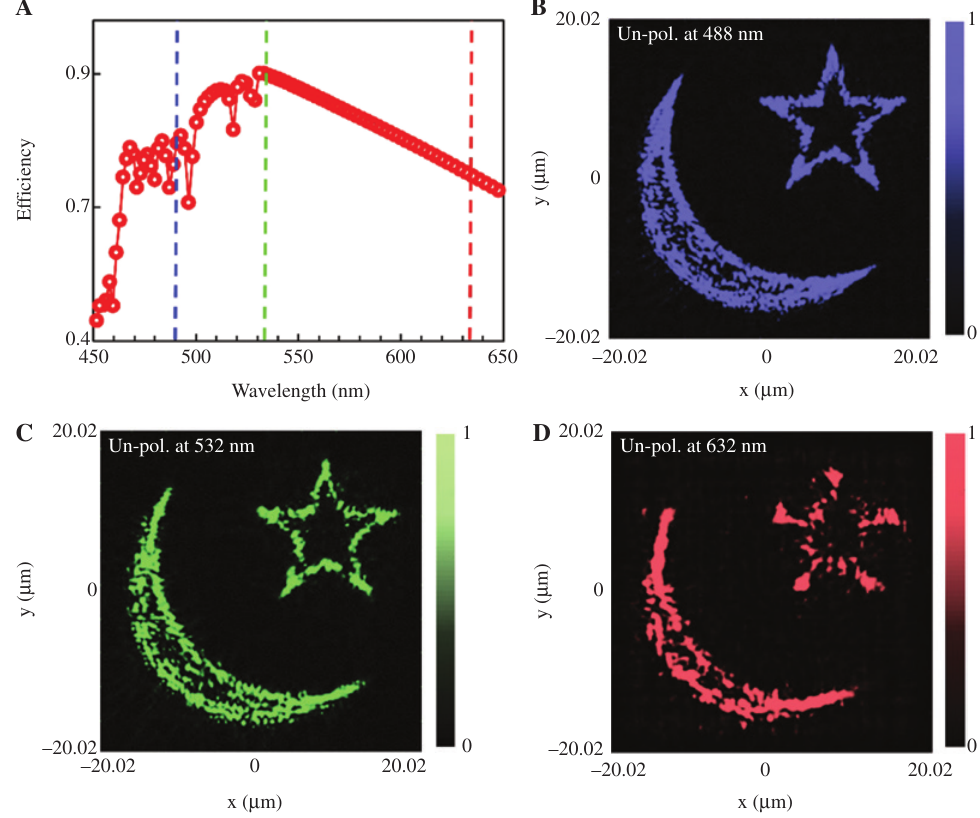
Figure 4: Broadband metahologram under unpolarised light incidence. (A) The total efficiency of metahologram across the visible domain (from 450 nm to 650 nm). The colored vertical lines represent the efficiencies at their corresponding wavelengths; for example, the green line is drawn at a wavelength of 532 nm, showing 90% efficiency. (B–D) Intensity profiles of reconstructed holographic images of the same metahologram under the (B) blue (488 nm) (C) green (532 nm) and (D) red (632 nm) unpolarised light illumination. The anisotropic-nanorods are optimised at a central wavelength of 532 nm and are